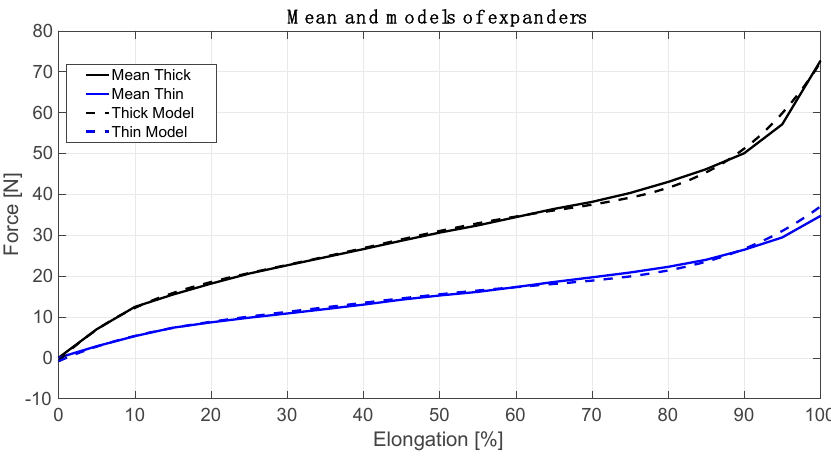
Figure 2. Mean and models of expanders characteristics .